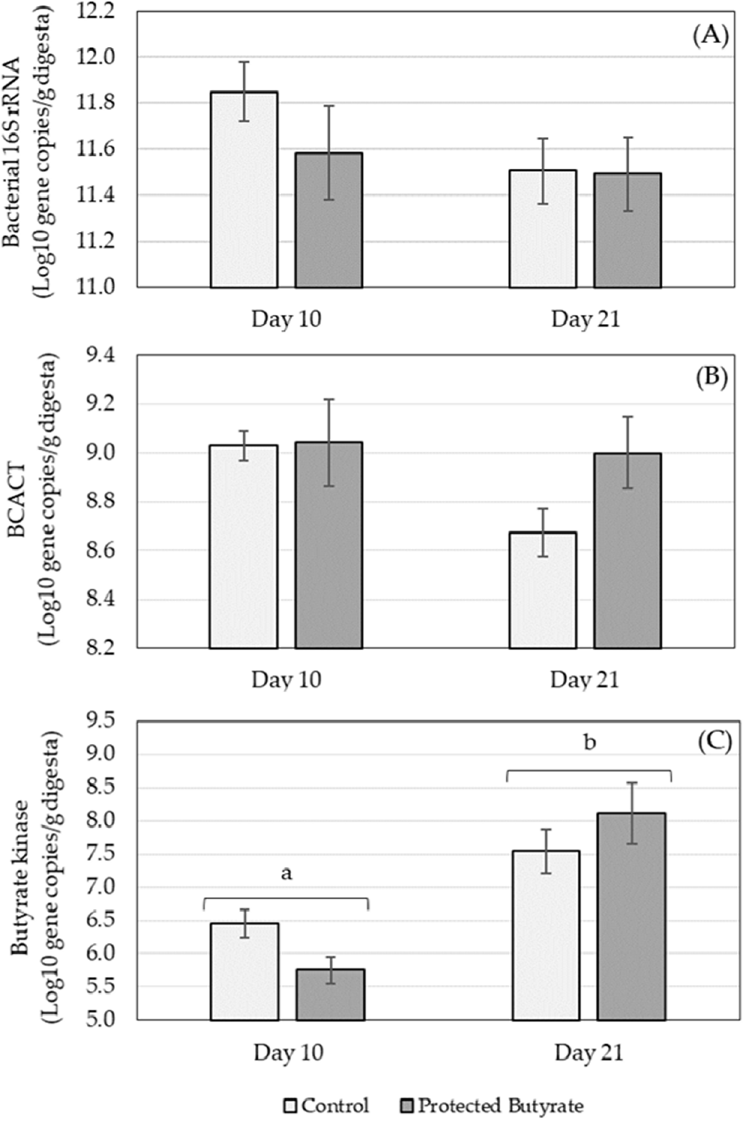
Figure 1. Concentration of gene copies in caecum ingesta of ( A ) bacterial 16S rRNA, ( B ) butyryl-CoA acetate CoA transferase (BCACT) and ( C ) butyrate kinase on different days of age (10 and 21) in broilers treated with protected butyrate compared to the control group. Bars represent the group means and error bars the standard error of the mean. Bars labelled with different letters are significantly different in terms of age ( p ≤ 0.001).